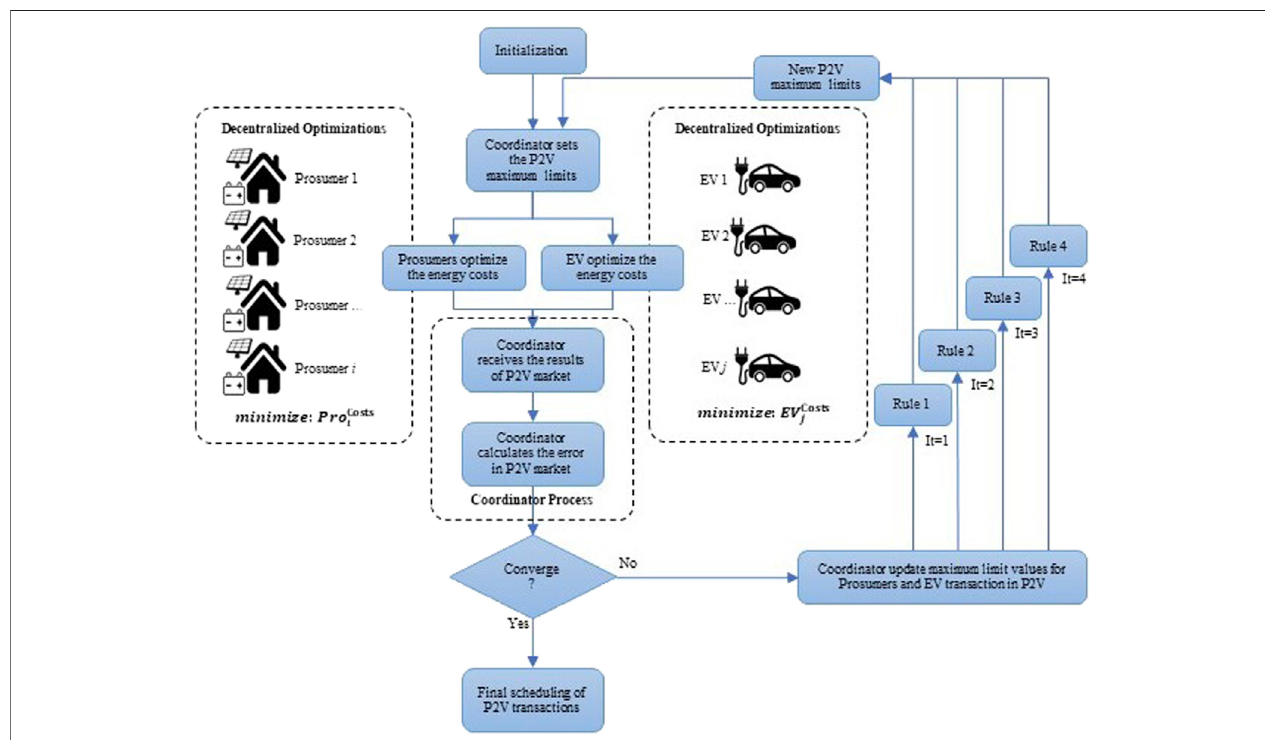
FIGURE 2 | Block diagram